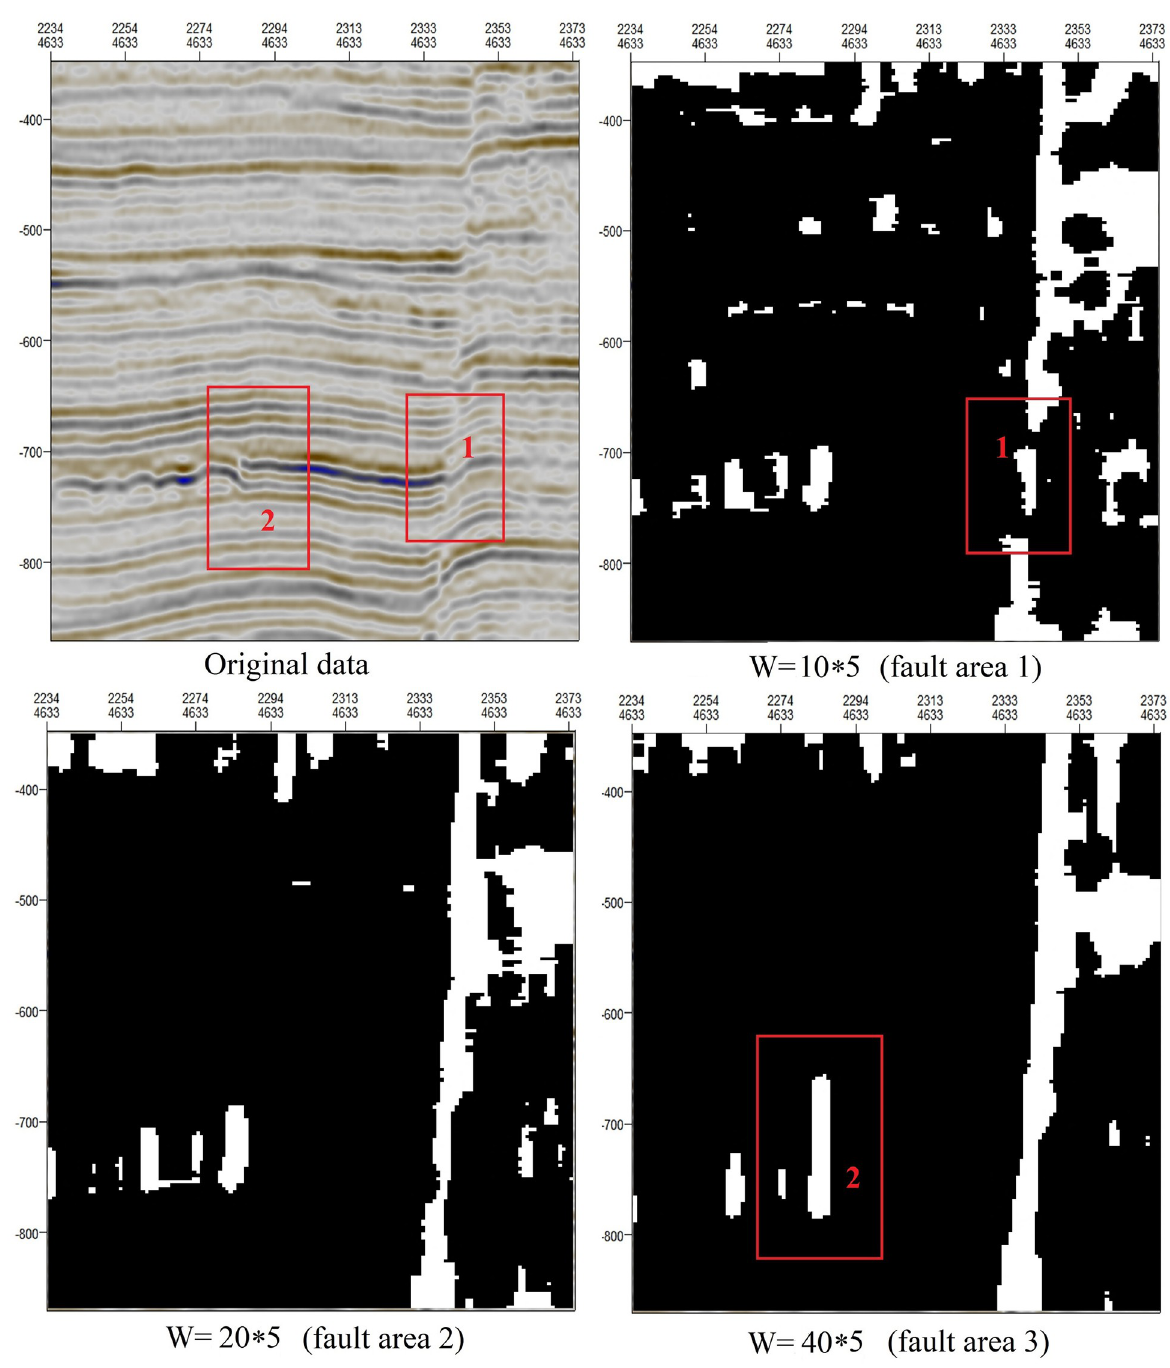
Fig 9. Influence of different values of m in the convolution kernel W on the extracted fault areas.